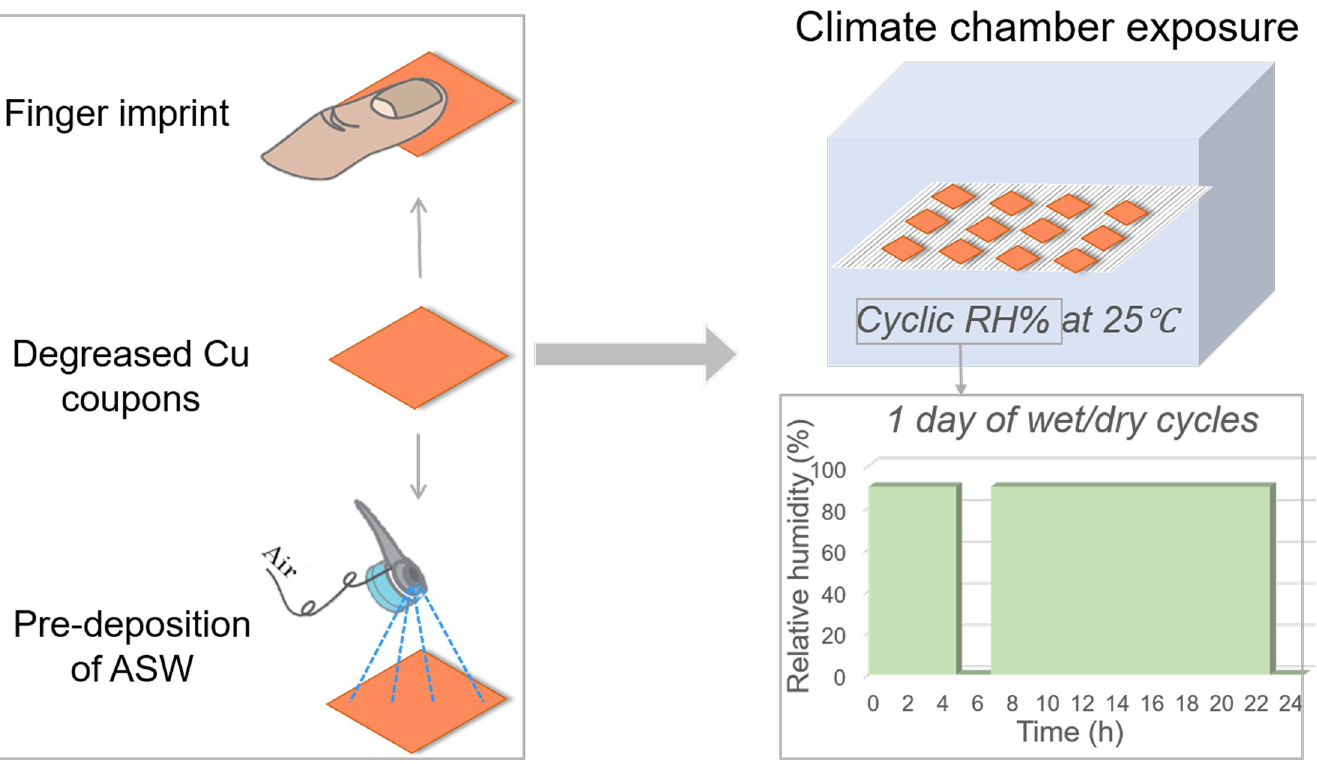
Fig 1. Illustration of sample preparation and the wet/dry cyclic laboratory exposure conditions in a climate chamber.